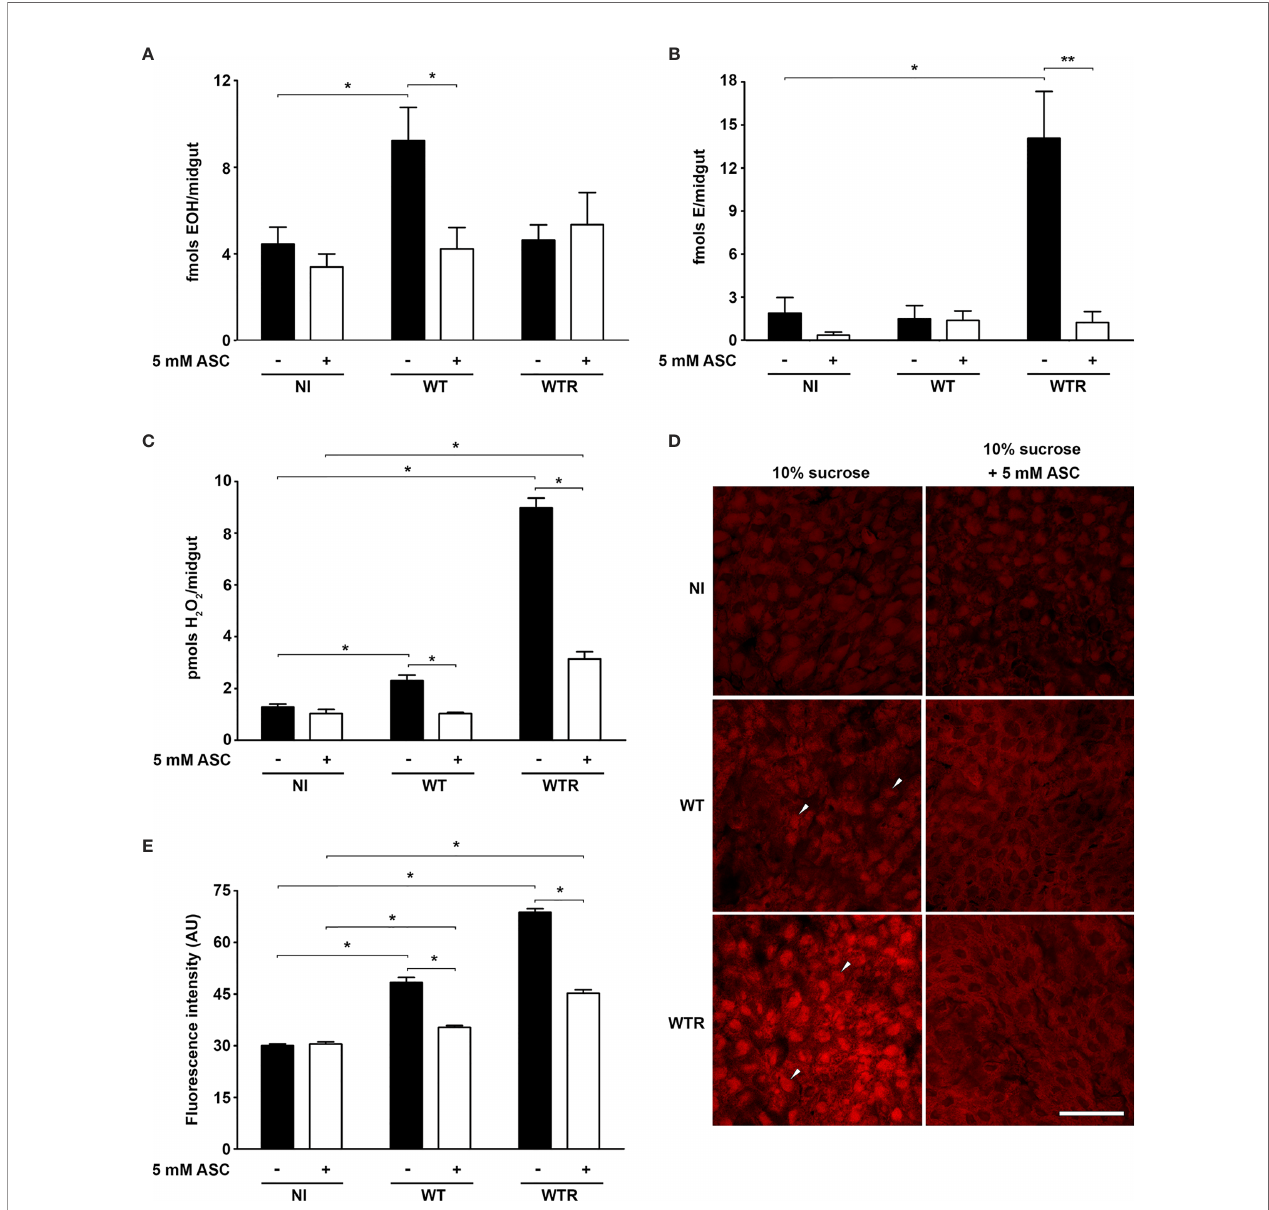
FIGURE 1 | Strigomonas culicis infection in midgut elicited a reactive oxygen species (ROS)-dependent response in Aedes aegypti. Analysis was performed in midguts of non-infected (NI), wild-type (WT) and hydrogen peroxide (H 2 O 2 )-resistant (WTR)- infected females fed with 10% sucrose or 10% sucrose + 5 mM sodim L-ascorbate (ASC) ad libitum 4 dpi. High-performance liquid chromatography (HPLC) analysis of dihydroethidium (DHE) oxidation products (A) hydroxyethidium (EOH) (*p = 0.02) and (B) ethidium E (*p = 0.03 and **p = 0.02) and (C) total H 2 O 2 production measurement (*p = 0.05). Assays were performed in technical replicate with pools of 10 – 15 guts. (D) Representative confocal images of midguts dissected and incubated with DHE. Scale bar represents 40 µm. Arrowheads indicate high staining in the infected midgut. (E) Quantitative analysis of fl uorescence microscopy (*p = 0.001). Individual analysis of 10 – 15 midguts per group. Signi fi cant p-values were obtained by Mann – Whitney test, and error bars represent the mean ± SEM of at least three independent